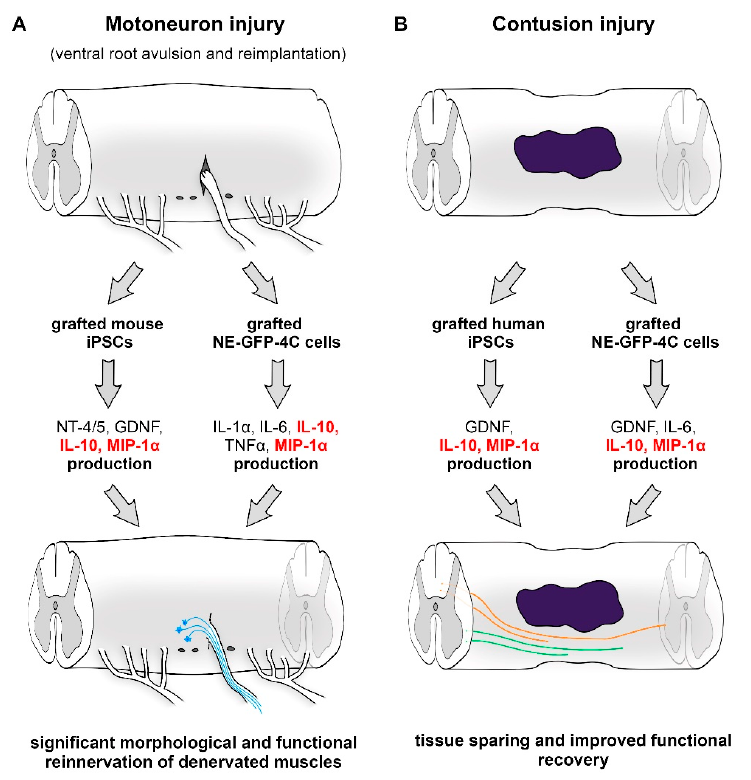
Figure 1. Various of lesion-induced secretome compositions in different spinal cord injury models. Partial overlap (IL-10 and MIP-1a) is observed between the two sets of bioactive molecules. ( A ) Following ventral root avulsion and reimplantation, the grafted cells produced various factors that induced significant functional motor reinnervation of the denervated muscles. ( B ) In a contusion injury model, the grafted cells expressed a set of proteins that significantly contributed to neuroprotection and improved the functional outcome of spinal cord injury.